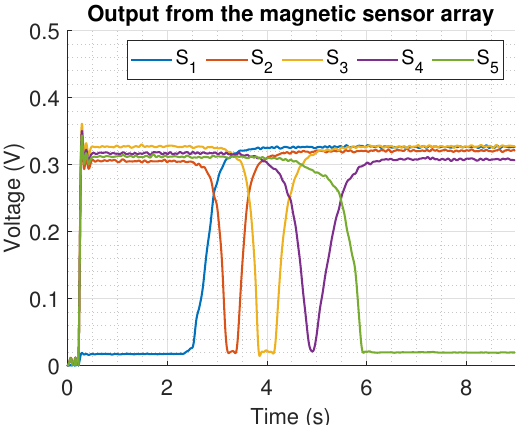
Figure 14. Measured output from the array sensor during the movement of the linear shaft from the position 0 mm to 59.9